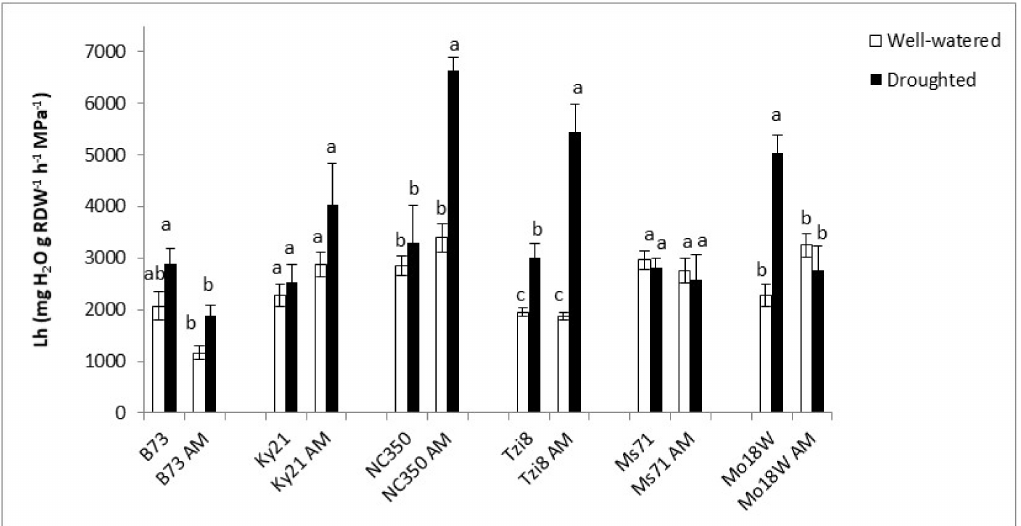
Figure 9. Hydrostatic root hydraulic conductivity (Lh) in six maize NAM lines (B73, Ky21, NC350, Tzi8, Ms71 and Mo18W) inoculated or not with an arbuscular mycorrhizal (AM) fungus. Plants were cultivated under well-watered conditions or subjected to drought stress. Data represents the means of 6 values ± S.E. Within each maize line, different letters indicate significant differences between treatments ( p < 0.05) based on Duncan’s